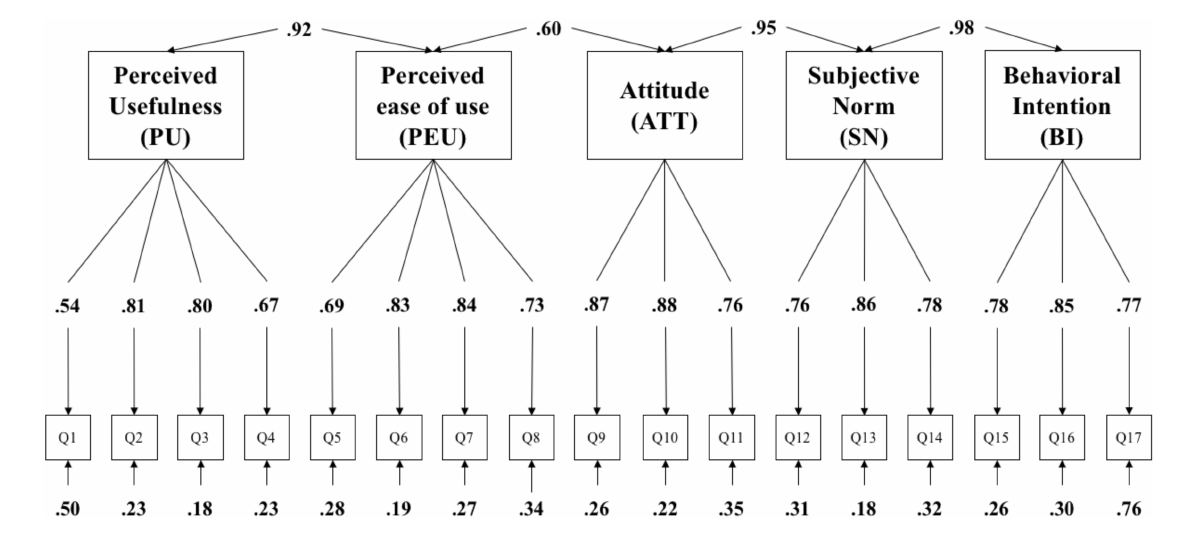
FIGURE2 Results of the confirmatory factor analysis (CFA) for the survey instrument.